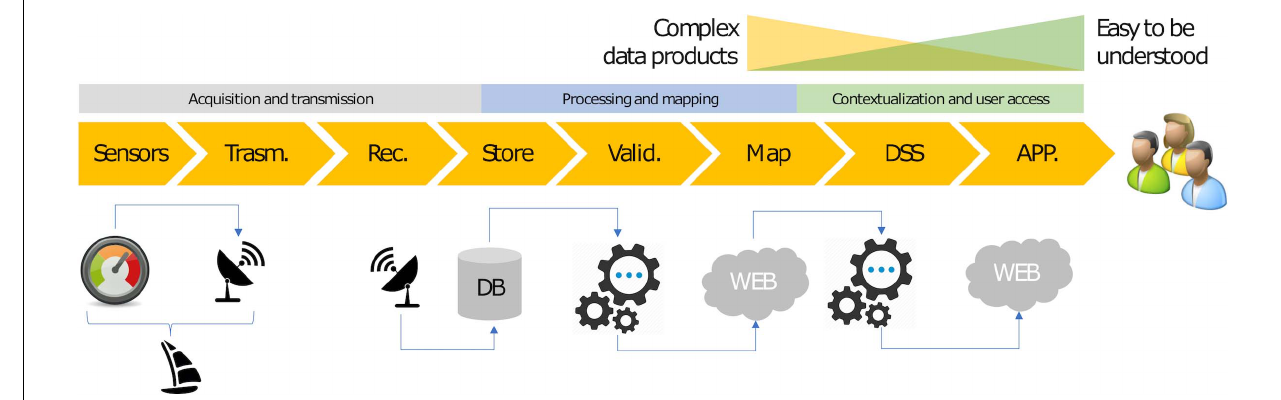
FIGURE 1 | The MaDCrow project